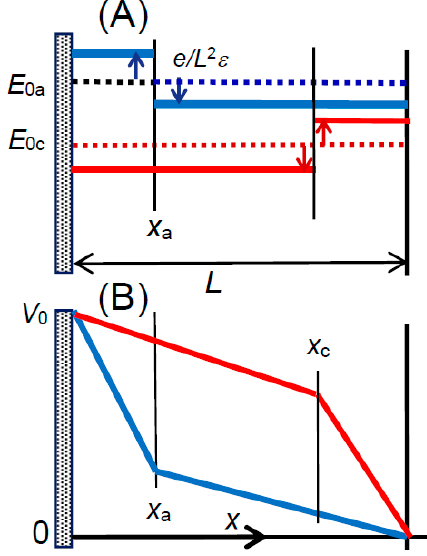
Figure 7. Profiles of ( A ) the electric fields and ( B ) the voltages along the axis (x) perpendicular to the electrode, where x a and x c are location of an anion and a cation.